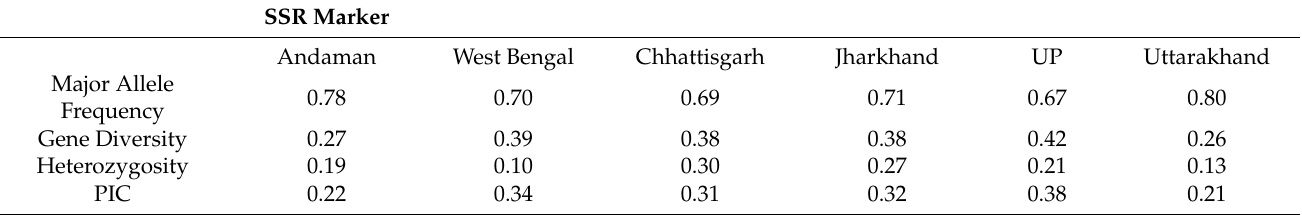
Table 1. Average values of major allele frequency, gene diversity, observed heterozygosity, and pic according to landraces’ geographical